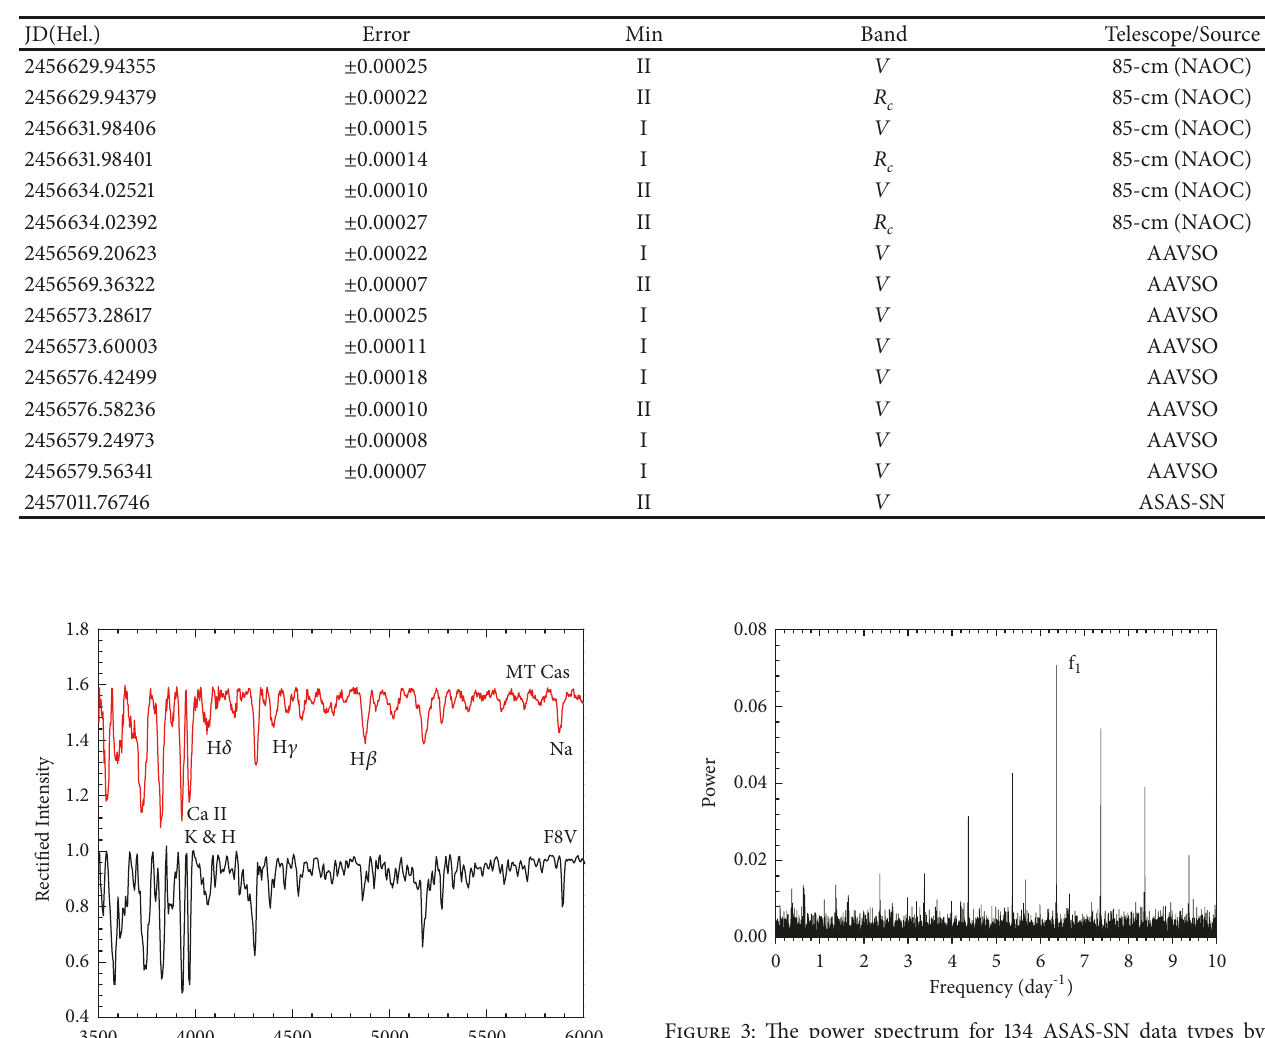
Table 2: New observed light minimum times.